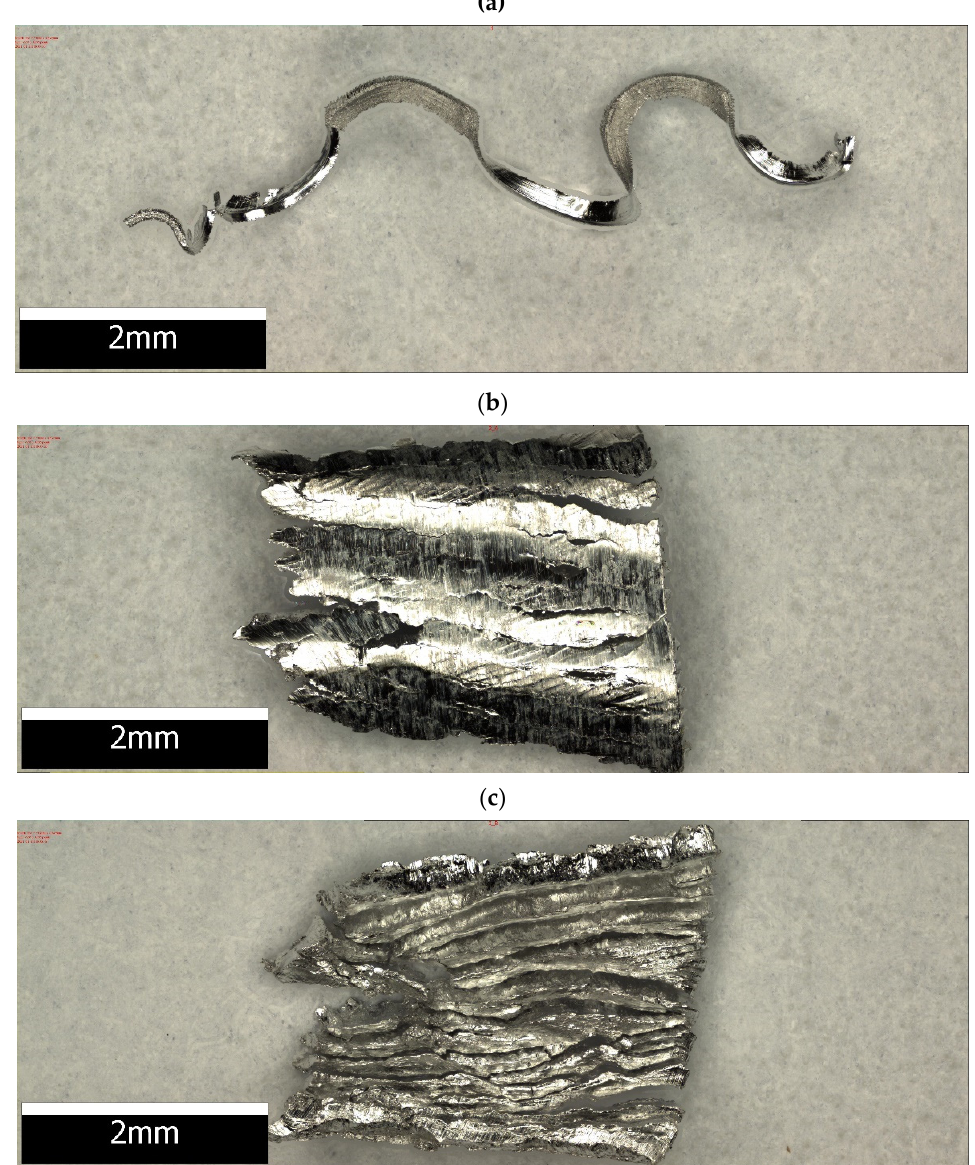
Figure 10. Optical imaging of chip geometry: ( a ) general view, ( b ) rake face side view and ( c ) free side view.